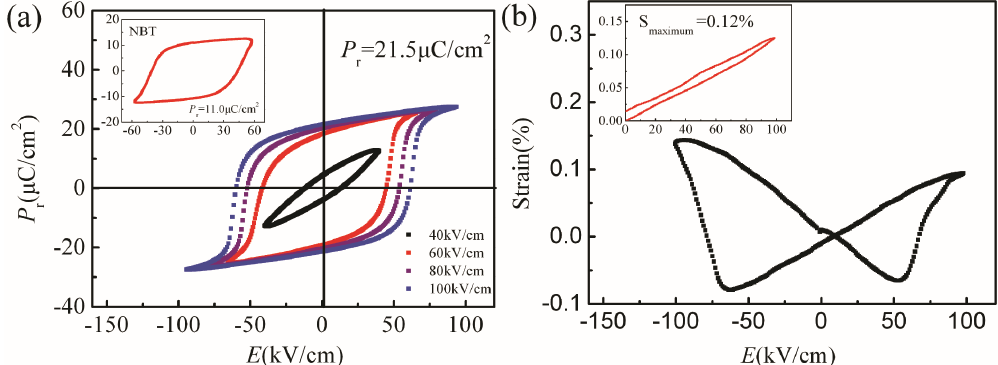
Figure 20. ( a ) P-E hysteresis loop and ( b ) S-E hysteresis loop for unpoled <001>-oriented NBT-1.5BZT crystal at room temperature. Reprinted with permission from [31]. Copyright 2014 John Wiley and